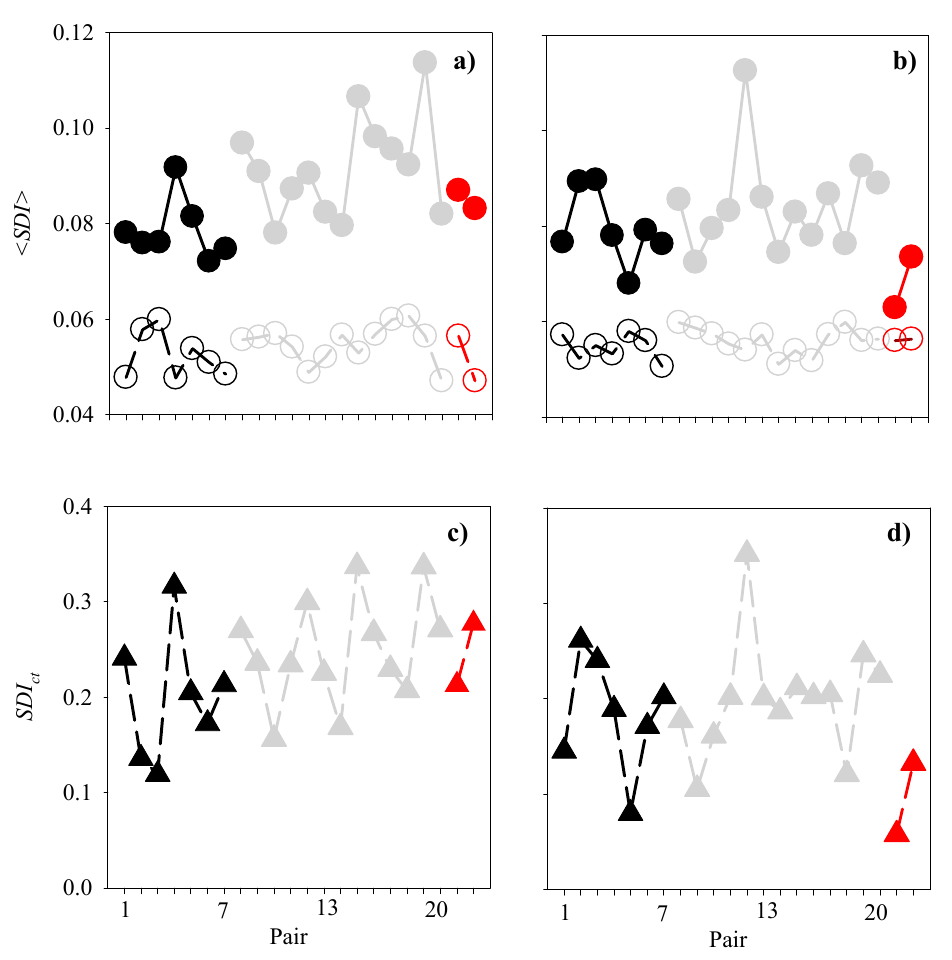
Figure 7. Structural dissimilarity of lidargrams as a function of time. <SDI> ( upper panels , a , b , circles), SDI ct ( lower panels , c , d , triangles). λ = 473 nm ( left panels , a , c ), λ = 532 nm ( right panels , b , d ), on-axis (solid circles), off-axis (empty circles); black (9:36–10:03 a.m.), grey (12:10–13:27) and red